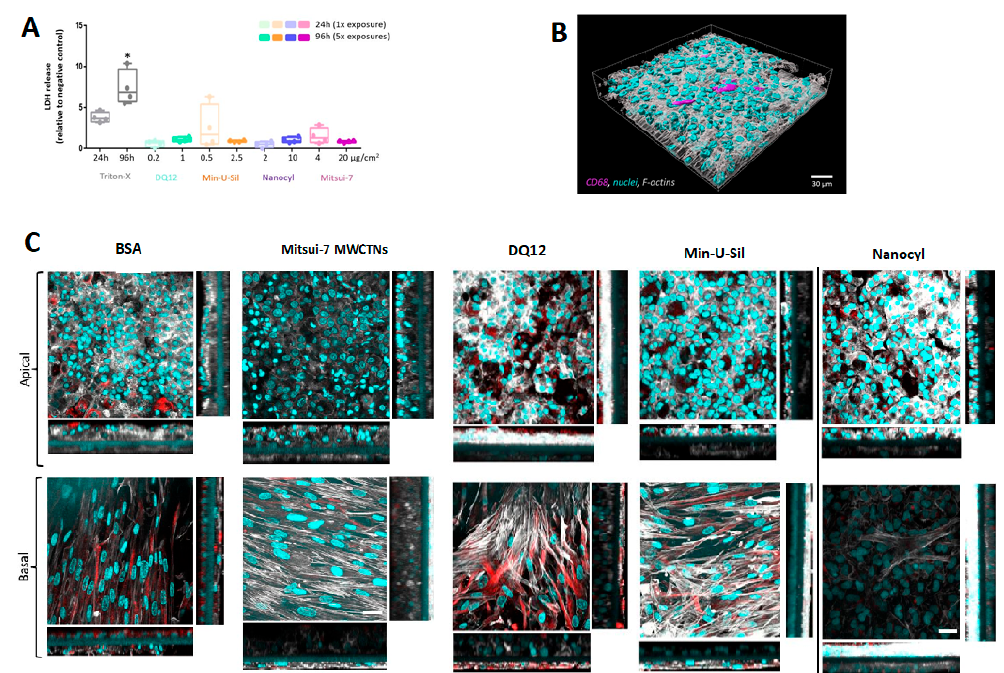
Figure 3. Cytotoxicity and cellular morphology of the 3D co-culture model. ( A ) Cytotoxicity was measured by the LDH assay, data presented in a boxplot with 10–90 percentile. * marks a statistically significant increase compared to the negative control, n = 4. ( B ) Representative 3D rendered LSM image of the co-culture model at a 24 h time point, presenting the localization of macrophages within the model. Cyan represents cell nuclei, grey shows cytoskeleton, and magenta stains the macrophages (CD68). ( C ) The LSM images (XY projections) of BSA- and Mitsui-7, DQ12, Min-U-Sil, and Nanocyl-treated samples at 96 h time-point with their corresponding XZ projections showing thickness of the cellular layer, the scale bar is 30 µ m. Cyan represents cell nuclei, grey represents cytoskeleton, and red represents vimentin, a type III intermediate filament protein. For 3D rendered LSM images of the co-culture model at 96 h time-point, please refer to the Supplementary Materials, Figure S1–S5. The scale bar is 30 μ m.